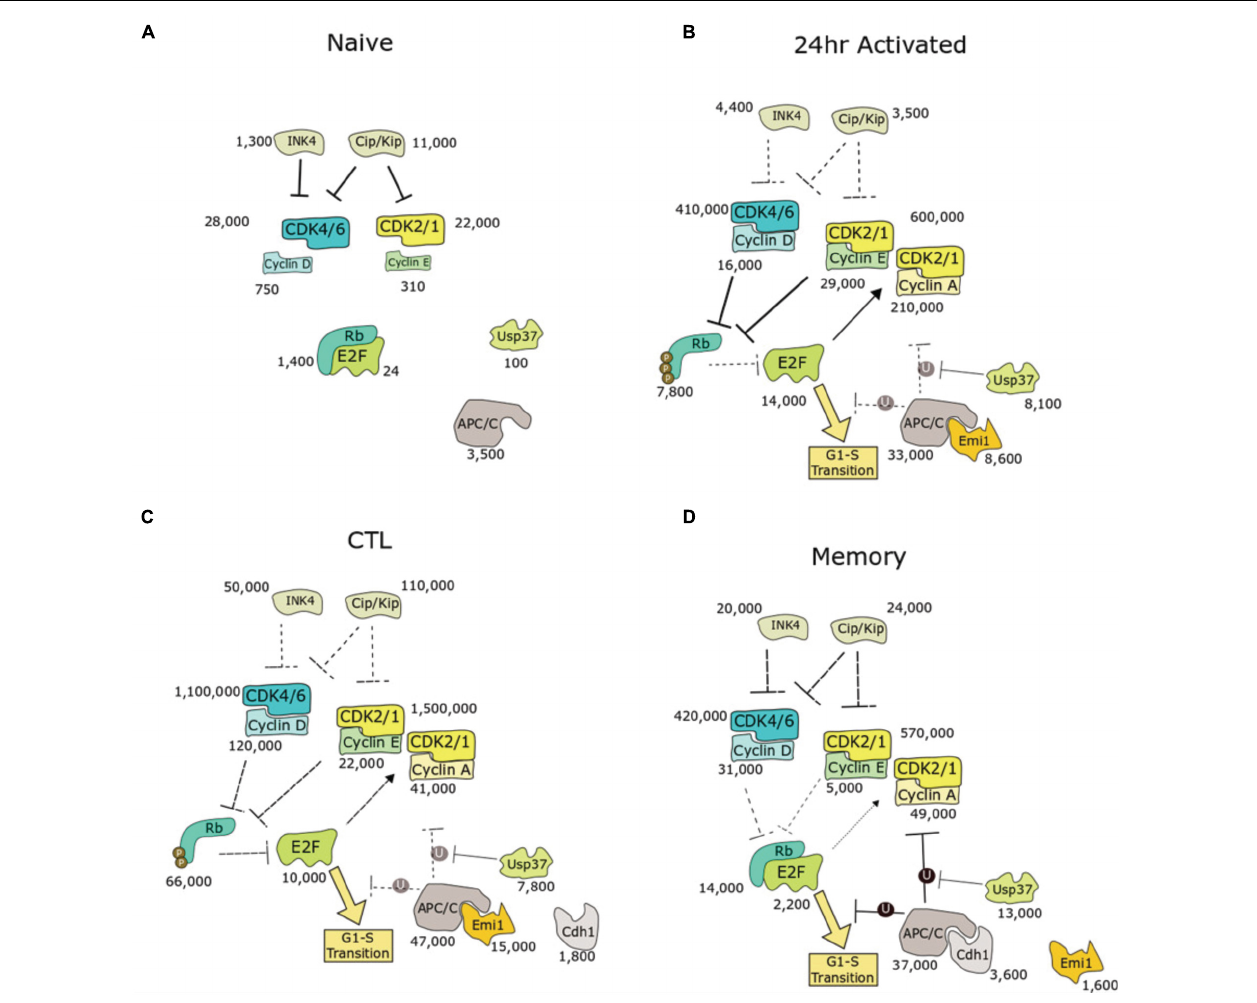
FIGURE 3 | Biochemical pathway analysis of cell cycle entry in murine CD8 + T cells with protein copies measured by quantitative proteomics. Four populations were presented: (A) quiescent naive, (B) activation phase, (C) expansion phase toward SLEC phenotype, or (D) expansion phase toward MPEC phenotype. Numbers indicate copy number of each protein as determined by quantitative proteomics, acquired from Immpress (“ImmPRes.co.uk,” University of Dundee). For protein families (e.g., INK4, CIP/KIP, cyclins, and CDKs), summed copies are shown. E2F copies represent the sum of E2Fs 1–3. Median subunit copy number is shown for the APC/C. Mechanisms predicted to be dominant are highlighted in bold lines, whereas suppressed pathways are indicated by dotted lines. P, phosphorylation; U,